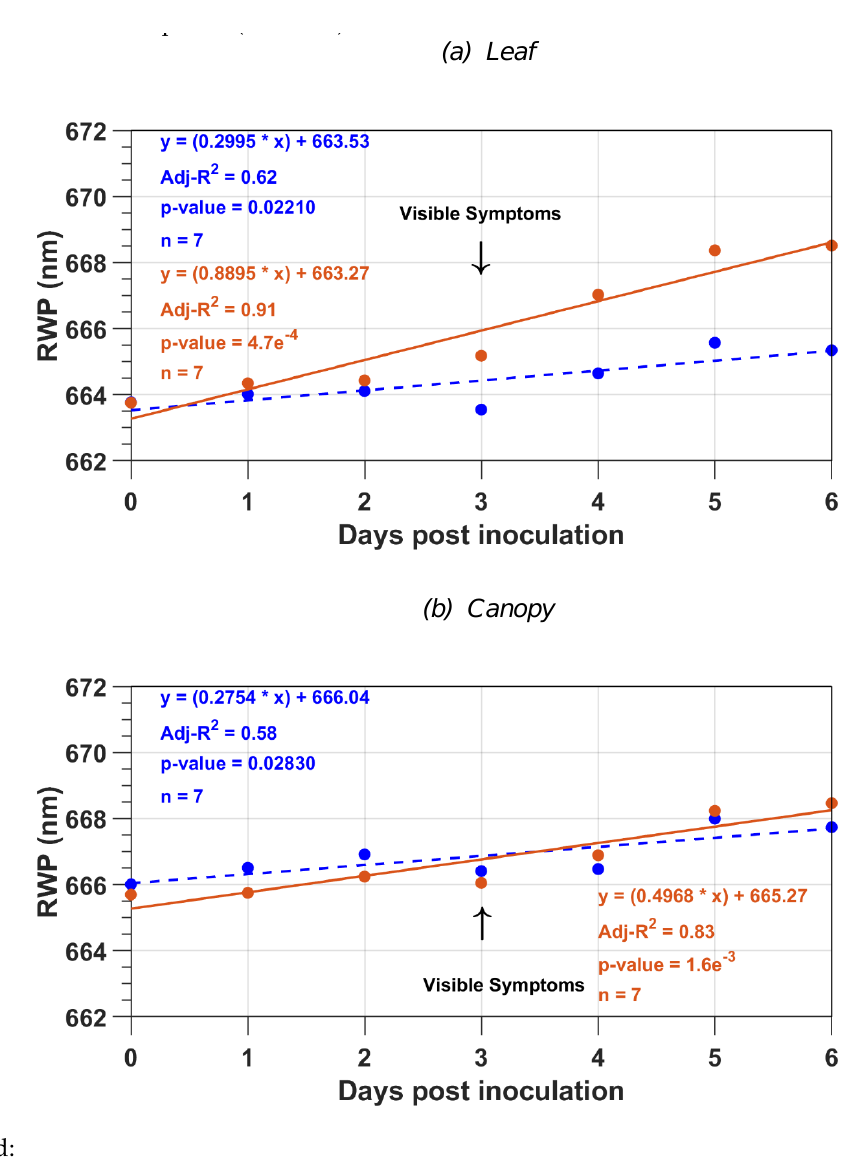
Figure 7. Linear regression model fitted with the mean red-well point (RWP) wavelength (in nm) for ( a ) the leaf and ( b ) canopy levels as a function of the number of days